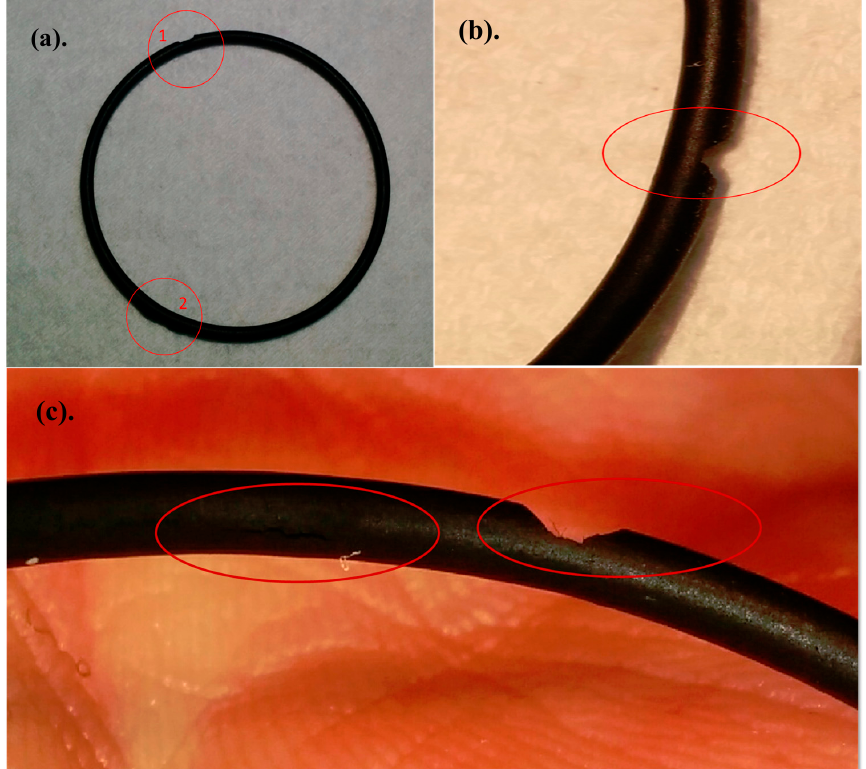
Figure 5. Blistering on the Kalrez 6375 O-ring elastomer upon increasing the temperature to 323.15 K. ( a ) Area showing two chunks of the elastomer missing, labelled 1 and 2, ( b ) large chunk missing on the outer edge of the O-ring, ( c ) large chunk missing on the outside with some blistering on